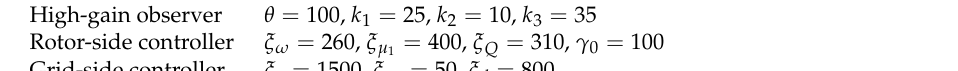
Table 3. Sensorless finite-time controllers’ parameters.